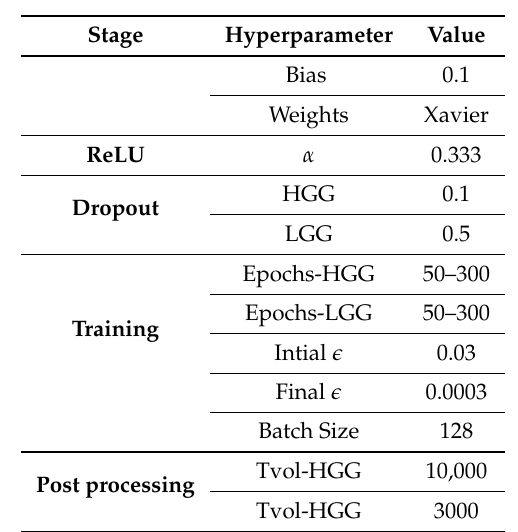
Table 4. Hyperparameters for our proposed technique.